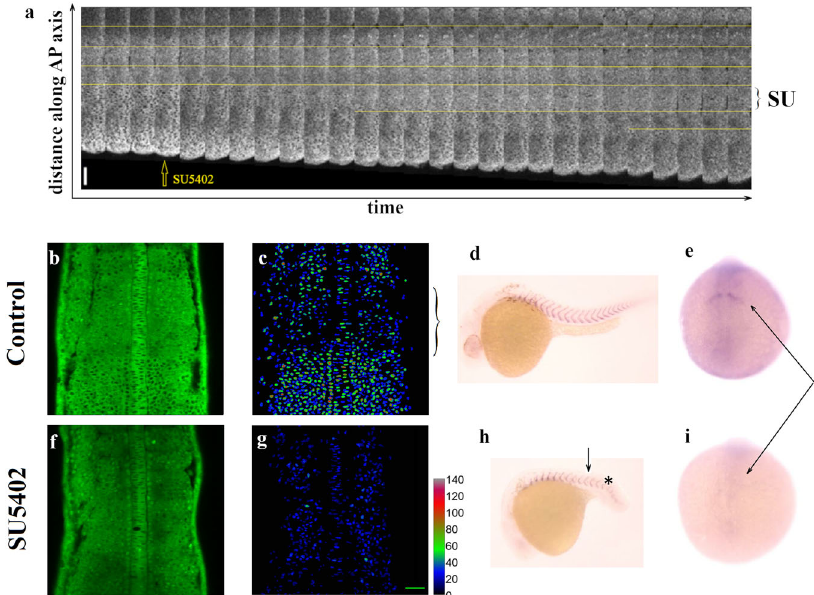
Fig. 2 Somitogenesis at low Erk activity. a Time lapse observations of the Erk activity domain in DREKA embryos following exposure to a low (50 μ M) concentration of SU5402 (an inhibitor of the Fgf pathway). The time span between images is 4 min. (the period of the clock in this experiment is about 45 min.) The yellow lines point to the boundary of Erk activity which periodically jumps by about 50 μ m except in the fi rst period after administration of SU5402 where the jump is larger (labeled as SU). Scale bar: 50 μ m. b – e Normal somitogenetic development in DREKA embryos (control). b Erk activity in DREKA embryos at 14 somite stage: dark nuclei point to high Erk activity. c The false color images represent the Erk activity averaged over a 30 μ m perpendicular stack of images. Notice the low activity area in the pre-pattern region (shown by the bracket) at the anterior PSM. d In situ hybridization (ISH) against xirp2a (a marker of somite boundaries) in 30 hpf embryos. e Immuno-Histochemical (IHC) staining against Mesp2a, a determinant of the last somite boundary (arrow). f – i Somitogenetic development in DREKA embryos in presence of a high (200 μ M) concentration of SU5402 from the 10 somite stage (arrow in (h)). Somitogenesis is impaired past 13 somite stage (indicated by a * in h ) with unclear somite boundaries. f , g The Erk activity is repressed (low) throughout the PSM. h ISH against xirp2a in 30 hpf embryos. i The determinant of the last somite boundary (Mesp2a), shown by an arrow is absent past 13 somite stage in i but present in e . Scale bar: 50 μ